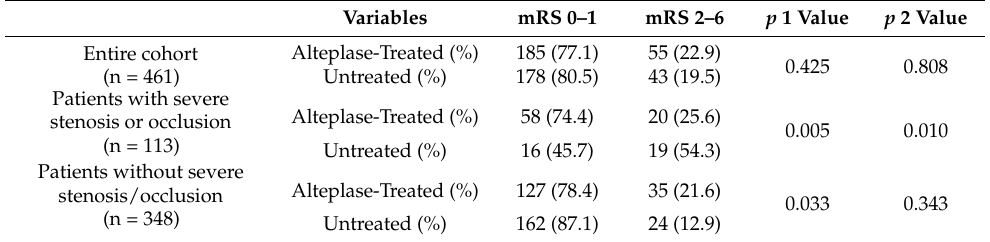
Table 3. Univariate comparison and binary logistic regression analysis for neurological